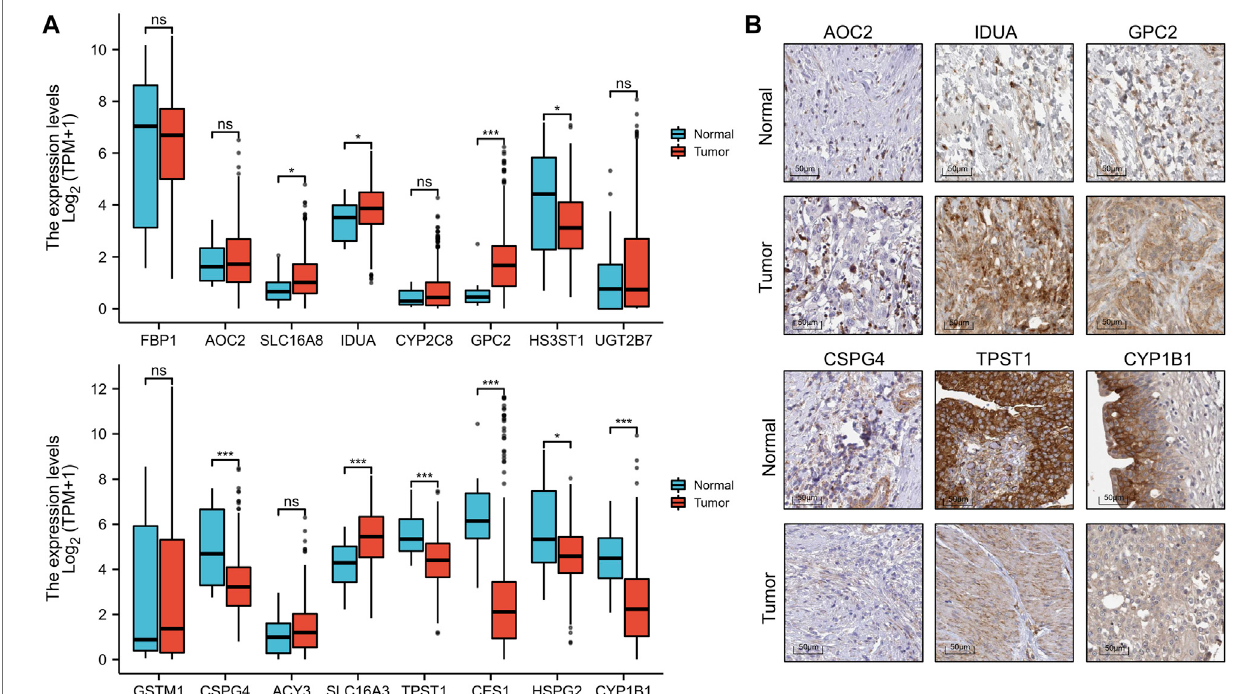
FIGURE7| Boxplot ofthe expression differenceof16genesinvolvedin theprognosticsignaturebetweennormaland BLCA tissue (A) . Theexpression difference ofAOC2,IDUA,GPC2,CSPG4,TPST1,andCYP1B1betweentumorandnormaltissueattheproteinlevelaccordingtotheHumanProteinAtlas(HPA)cohort. (B) .* p < 0.05, ** p < 0.01, *** p < 0.001.